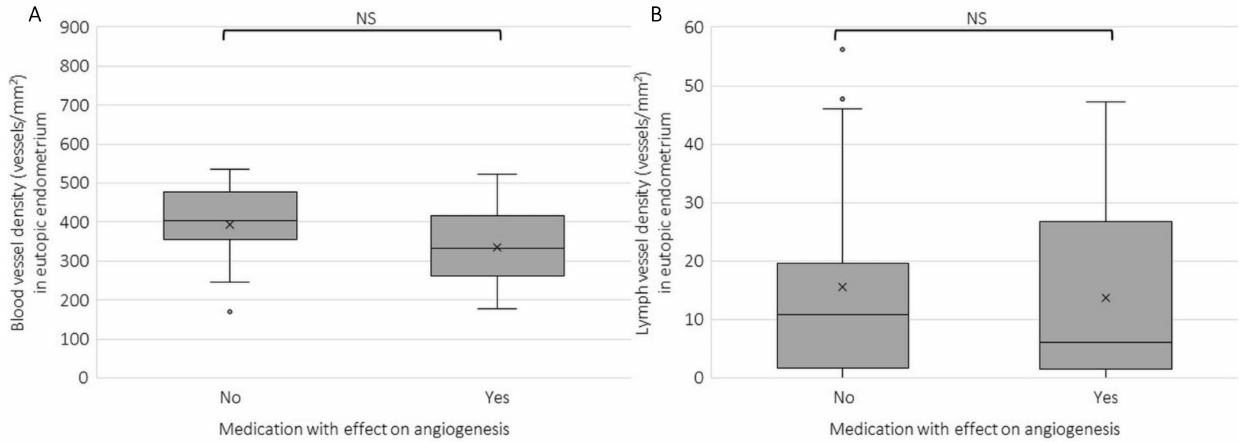
Figure 5. Boxplots of blood vessel density in the eutopic endometrium determined by the count of CD31 stained areas (vessels) per mm 2 CD10 stained area ( A ) and lymph vessel density determined by the count of podoplanin stained areas per mm 2 CD10 stained area ( B ) in the eutopic endometrium per medication use, with ‘no’ is no/other medication, and yes is NSAIDs/tranexamix acid. There were no significant differences in blood or lymph vessel density between patients who reported to use medication with an effect on angiogenesis. Data are shown as median ± range for all patient data pooled. NS: not